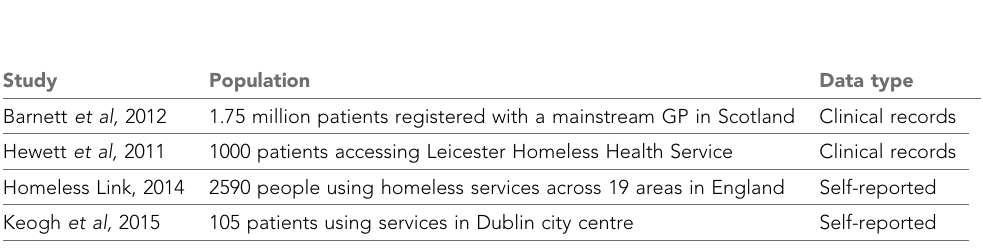
Queen A B et al . BJGP Open 2017; DOI: